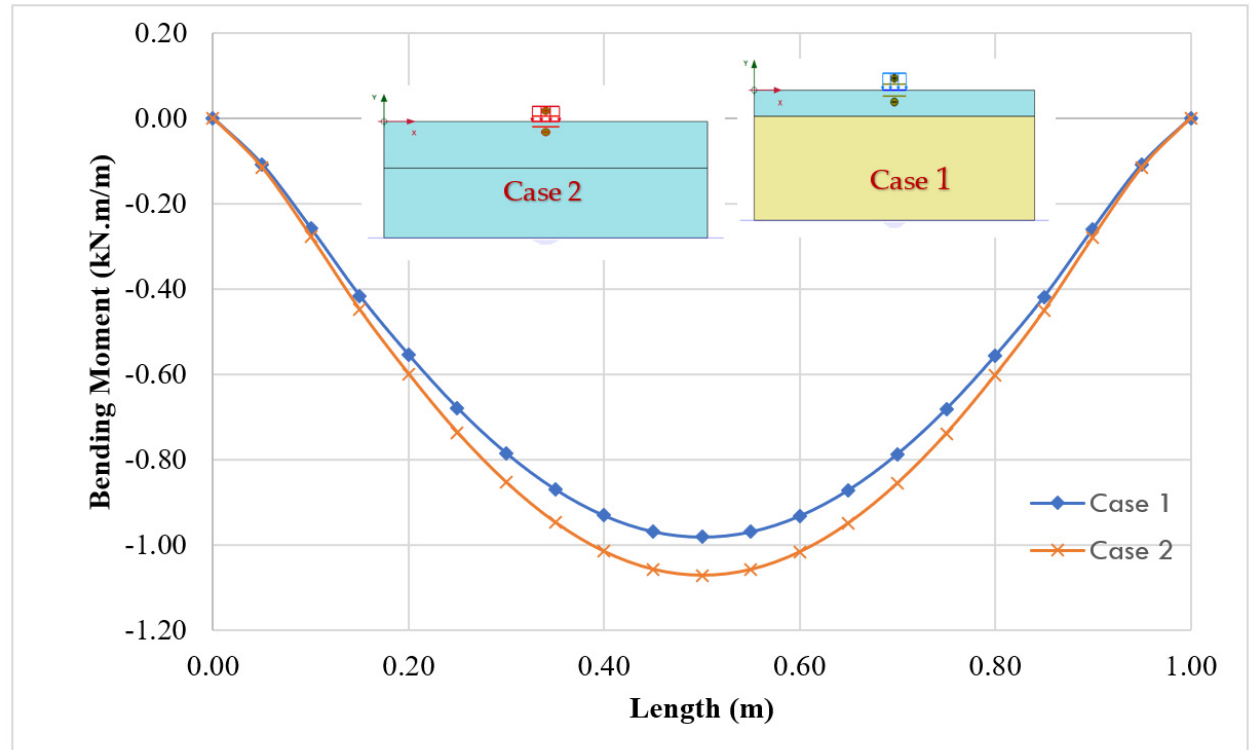
Buildings 2022 , 12 , x FOR PEER REVIEW Figure 7. Effect of the stiffness of the layer on the bending moment. Figure 7. Effect of the stiffness of the layer on the bending moment.